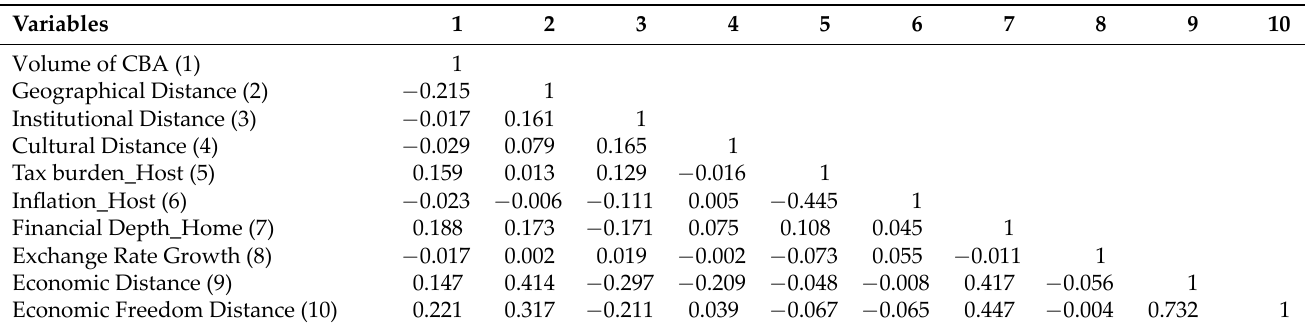
Table 3. Correlation matrix of all the variables.